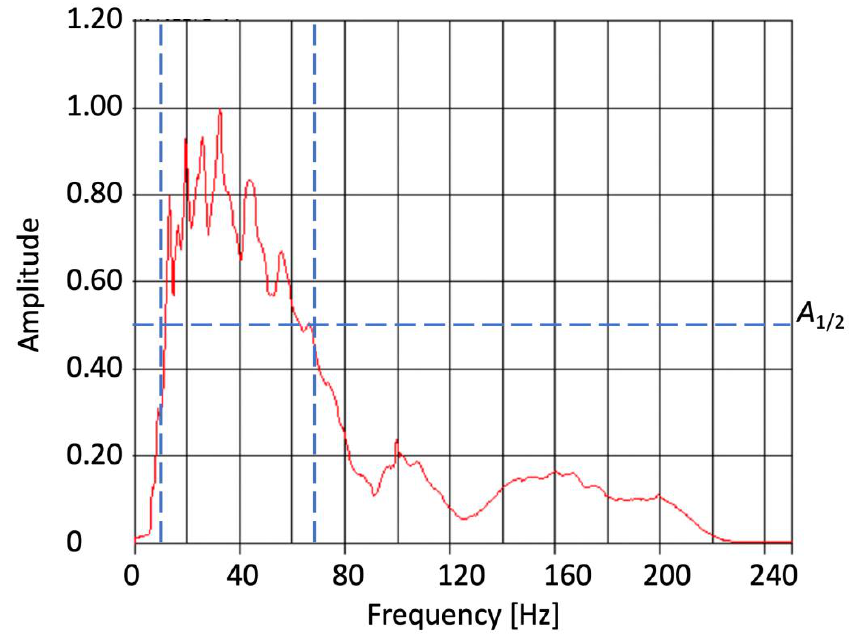
Figure 3. A frequency spectrum of the direct arrival in ISEM-2073-108 source #2290 records (red solid line). The frequency band (as defined by the half-amplitude taper 𝐴 1/2 ; blue dashed lines) is 20 to 70 Hz, with the peak frequency at 35 Hz.